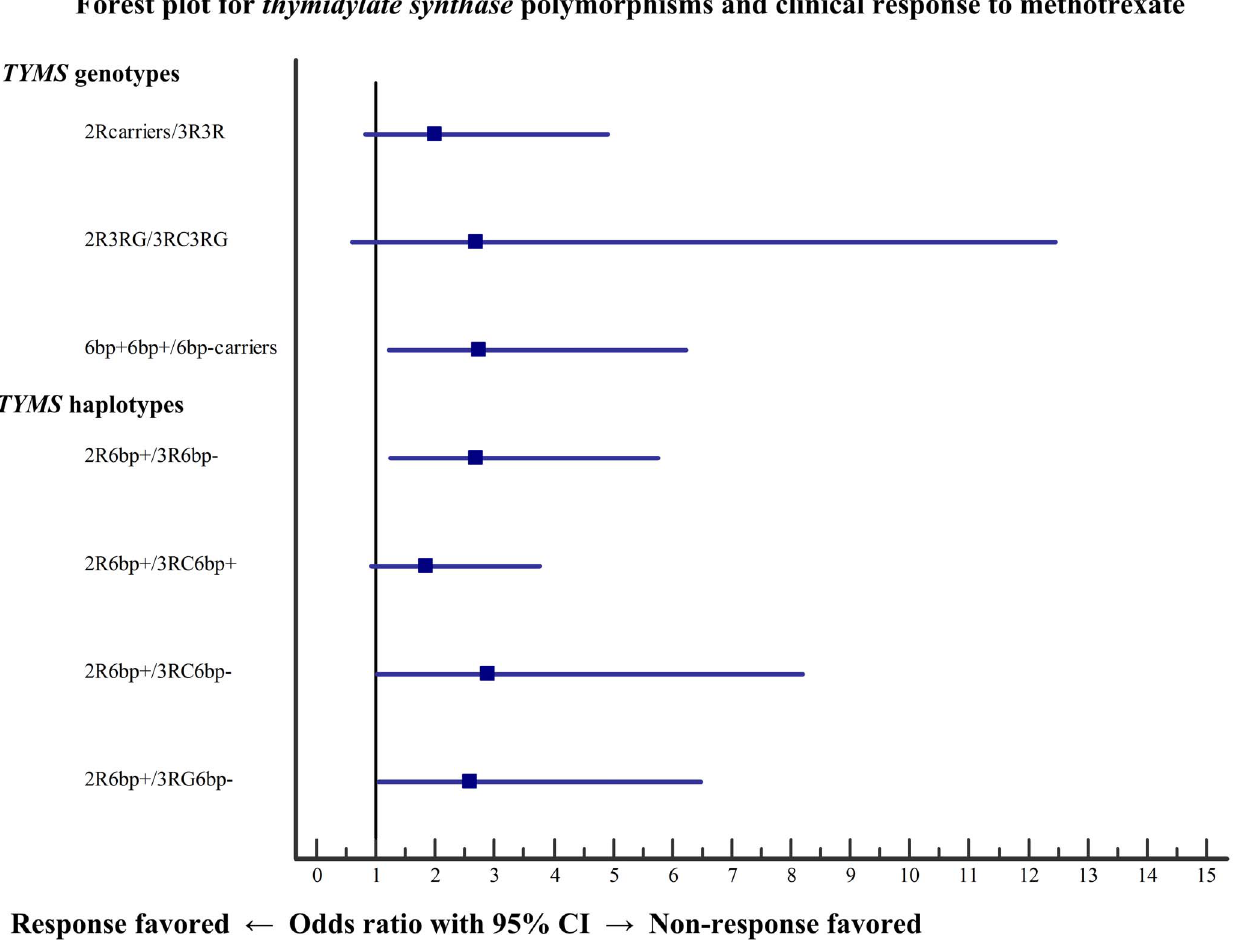
Figure 2. Forest plot of multivariate analysis in the association of thymidylatesynthase genotypes and haplotypes with clinical response to methotrexate. Odds ratio and 95% confidence intervals are reported for clinical response to methotrexate. bp: base pairs; C: cytosine; CI: confidence interval; del: deletion; G: guanine; R: repeat; TYMS: thymidylate synthase (gene).